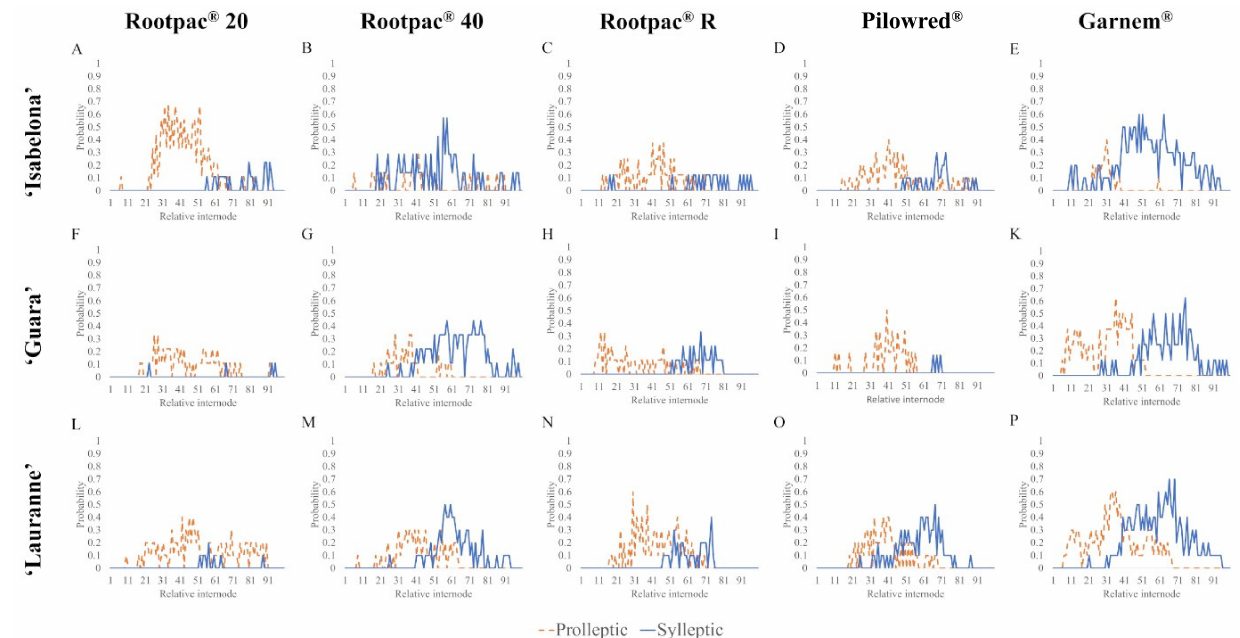
Figure 1. Probability of proleptic and sylleptic shoot occurrence according to nodal position along two-year-old branches of 15 scion/rootstock combinations of almond trees. Location of sylleptic shoots was recorded on one- and two-year-old wood, while proleptic shoots were recorded only on two-year-old wood. The probabilities of proleptic and sylleptic shoot formation at each node were converted to their relative position and represented in a branch with 100 internodes. Internode 0 refers to the base of the branch and internode 100 refers to the